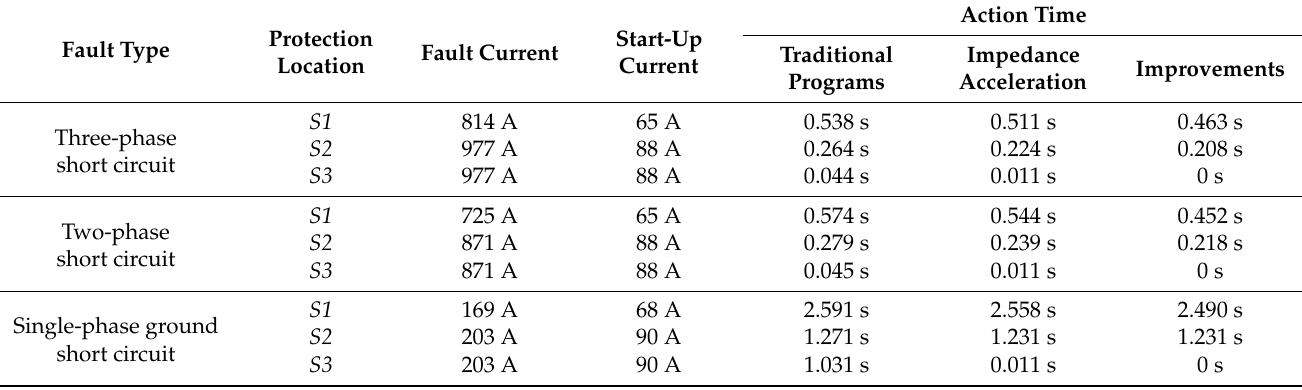
Table 3. Operating time of different protection schemes in the case of line CD via 0 Ω ground resistance fault.